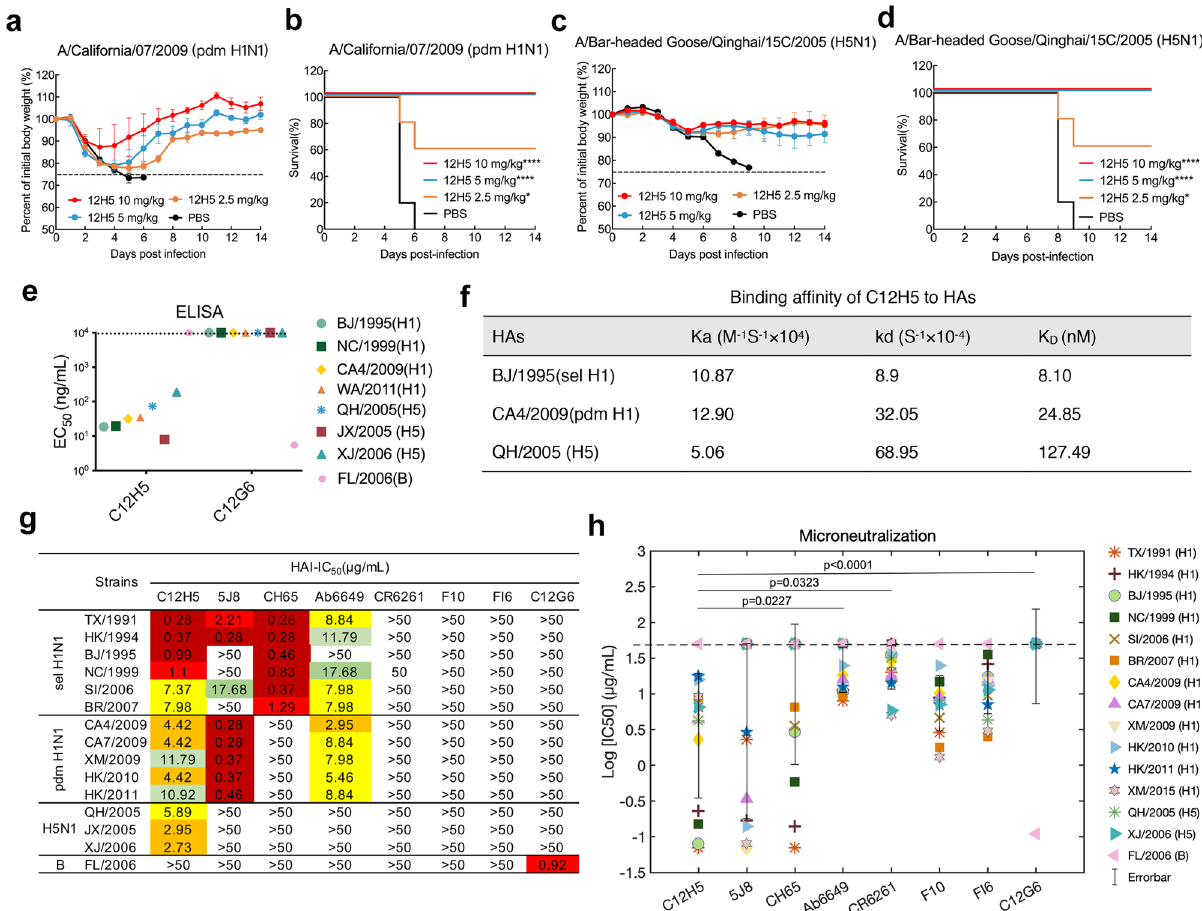
Fig. 1 | In vivo therapeutic ef fi cacy of 12H5 in mice and in vitro neutralization and binding activity of C12H5. a – d Therapeutic ef fi cacy of 12H5 against